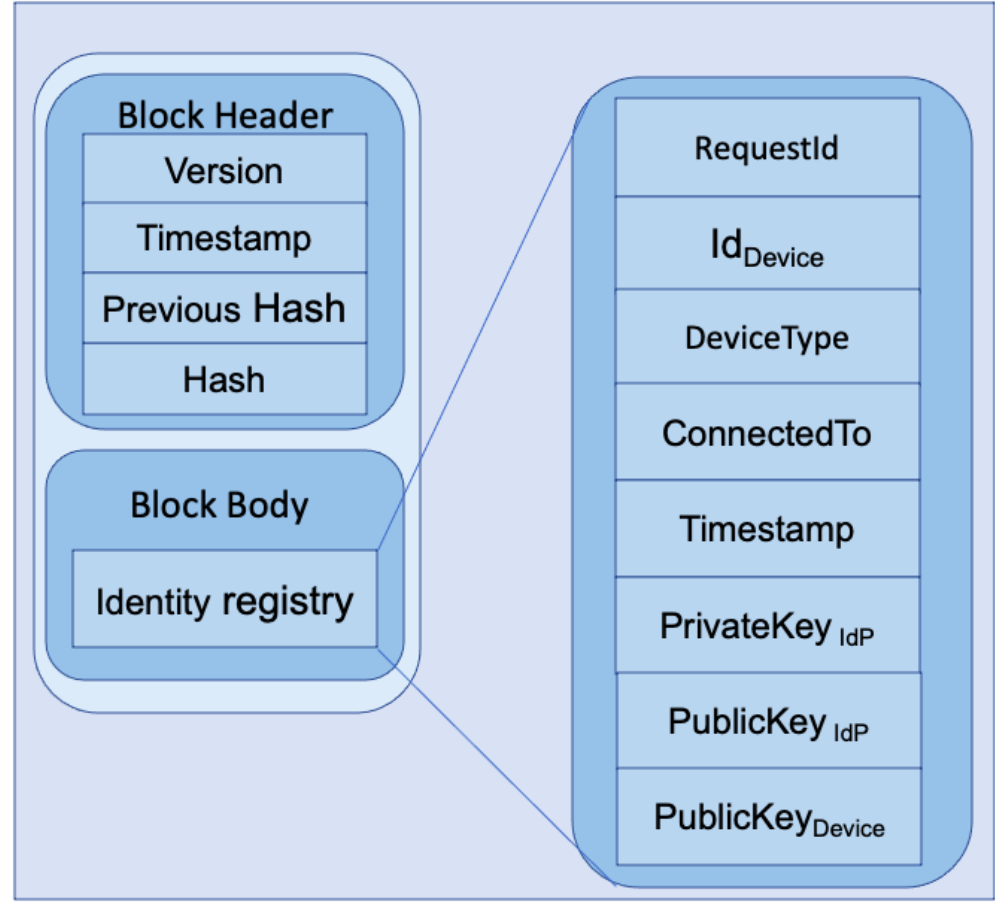
Figure 5. Internal architecture of a single block.